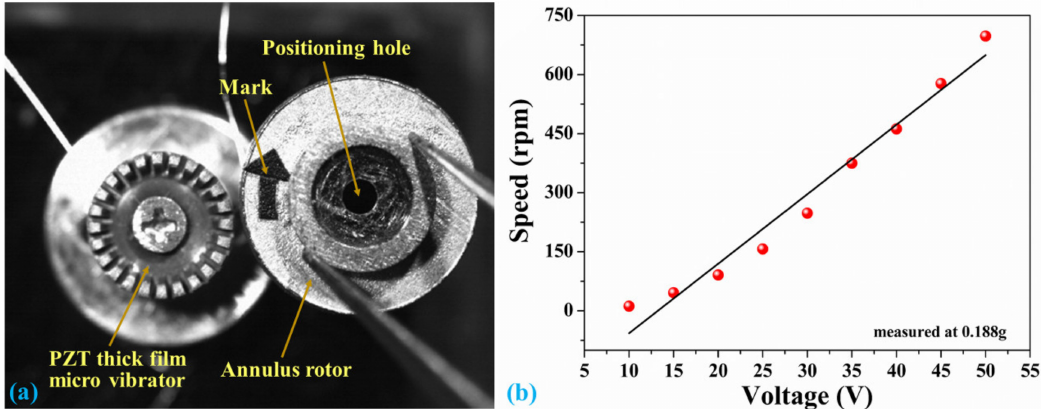
Figure 8. ( a ) PZT thick film micro vibrator and rotor and ( b ) the curve between excitation voltage and rotating